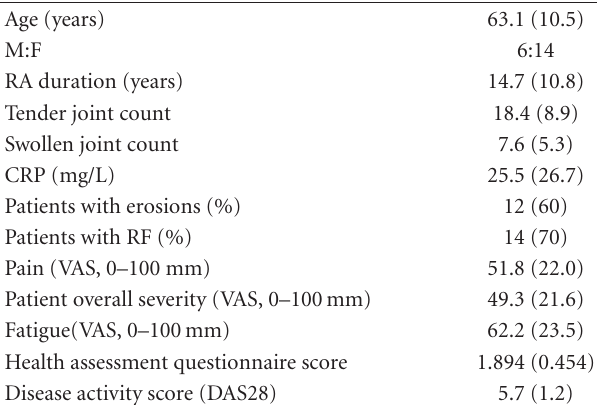
Table 1: Characteristics of patients ∗ .